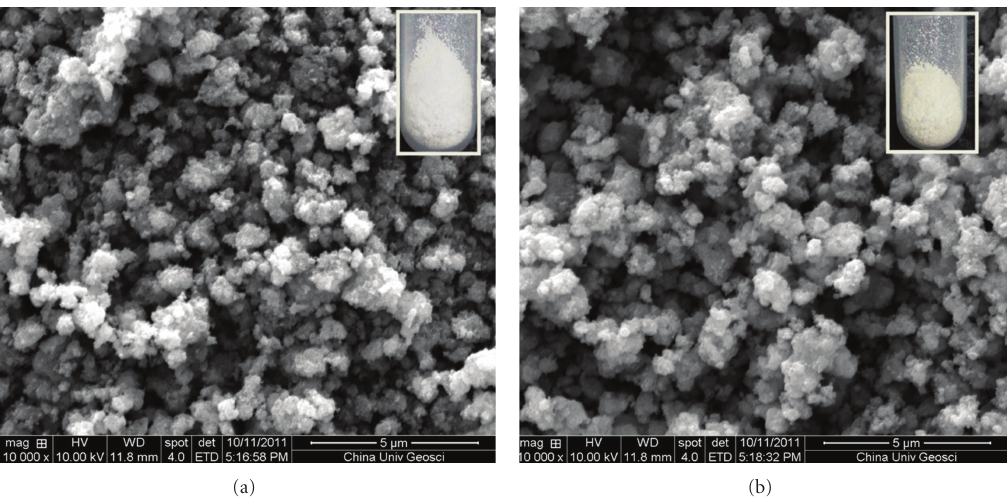
Figure 2: SEM image of commercial TiO 2 (a) and N-doped TiO 2 (b)